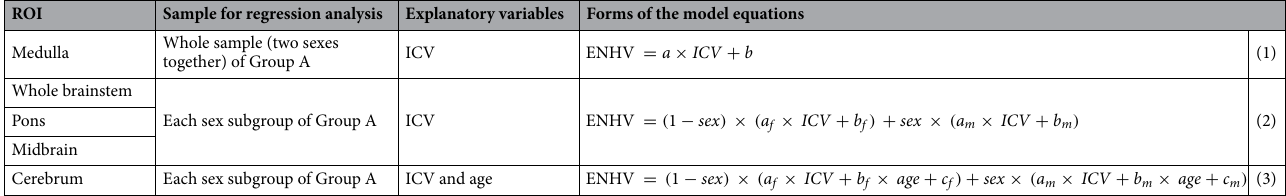
Table 2. Sample and explanatory variables of regression analysis and the model equation form. Each ROI and its corresponding model equation for estimating healthy volume are shown. The equations had three forms for the five ROIs. “ a f × ICV + b f ” or “ a f × ICV + b f × age + c f ” is the regression equation obtained in the regression analysis for the female subgroup, and “ a m × ICV + b m ” or “ a m × ICV + b m × age + c m ” is that for the male subgroup. sex = 1 for males/0 for females in Eqs. (2) and (3). ROI Region of interest, ICV Intracranial volume, ENHV Expected normal healthy